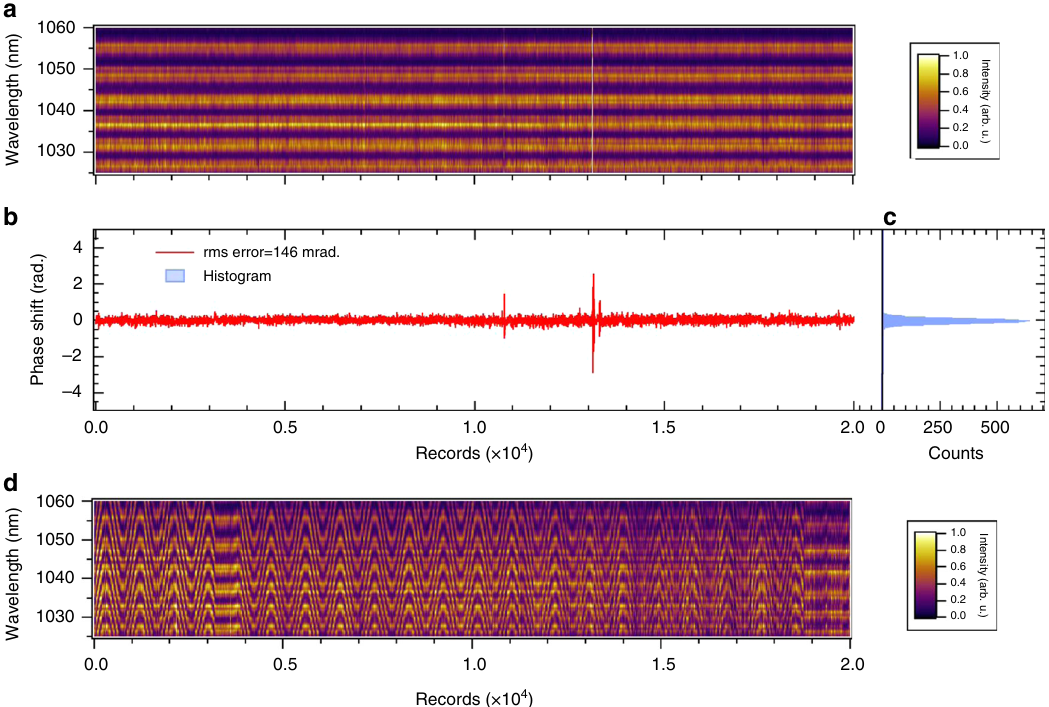
Fig. 3 CEP measurement after OPA2. a Temporal evolution of the f – 2 f spectral interference fringes originating from the output pulse from OPA2 under CEP stabilization control. We performed the three-shot accumulation of the spectrum for each record, and thus, the number of records (2.0 × 10 4 ) is equivalent to the recording time of 5 min by considering a pulse repetition period of 5 ms. b Relative phase shift (CEP) extracted from the spectrogram depicted in a . The rms error of the phase shift is estimated to be 146 mrad. c Histogram of the relative phase shift. The width of a bin is 0.01 rad (we set 100 bins/rad) in this histogram. d f – 2 f spectral interference fringes when we actively modulated the delay between the pump and seed pulses in OPA1 under CEP stabilization